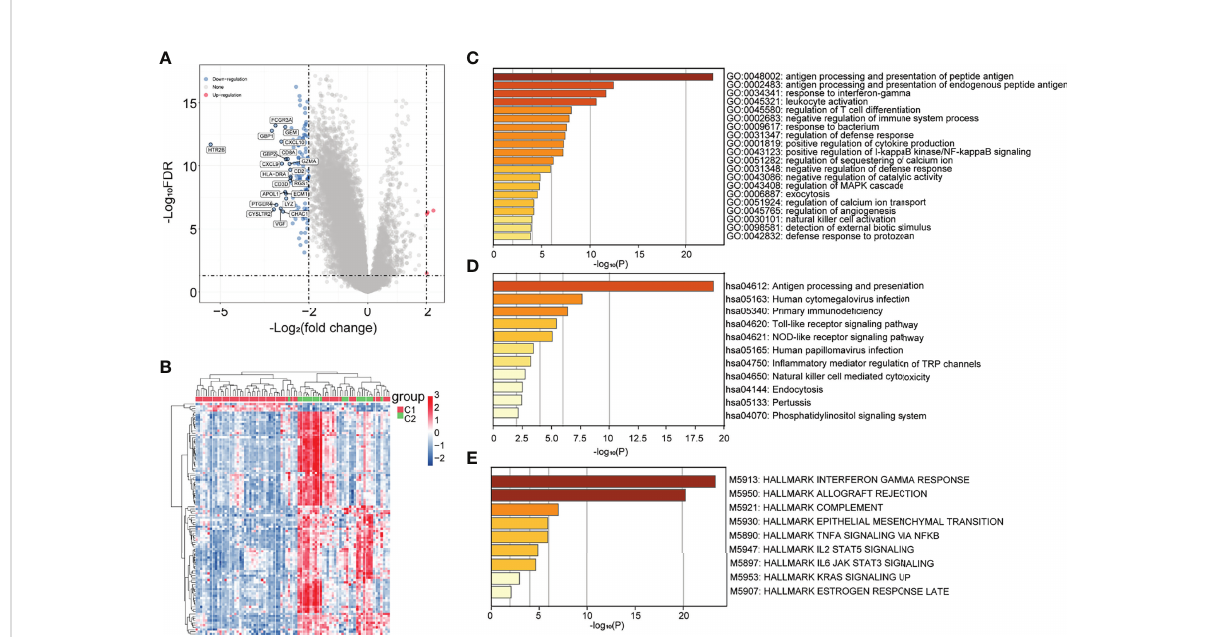
FIGURE 2 Differential analysis of subgroup gene expression in immune-related uveal melanoma (UM). (A) Volcano map; (B) heat map; (C – E) GO (BP only), KEGG, and Hallmark pathway enrichment maps.